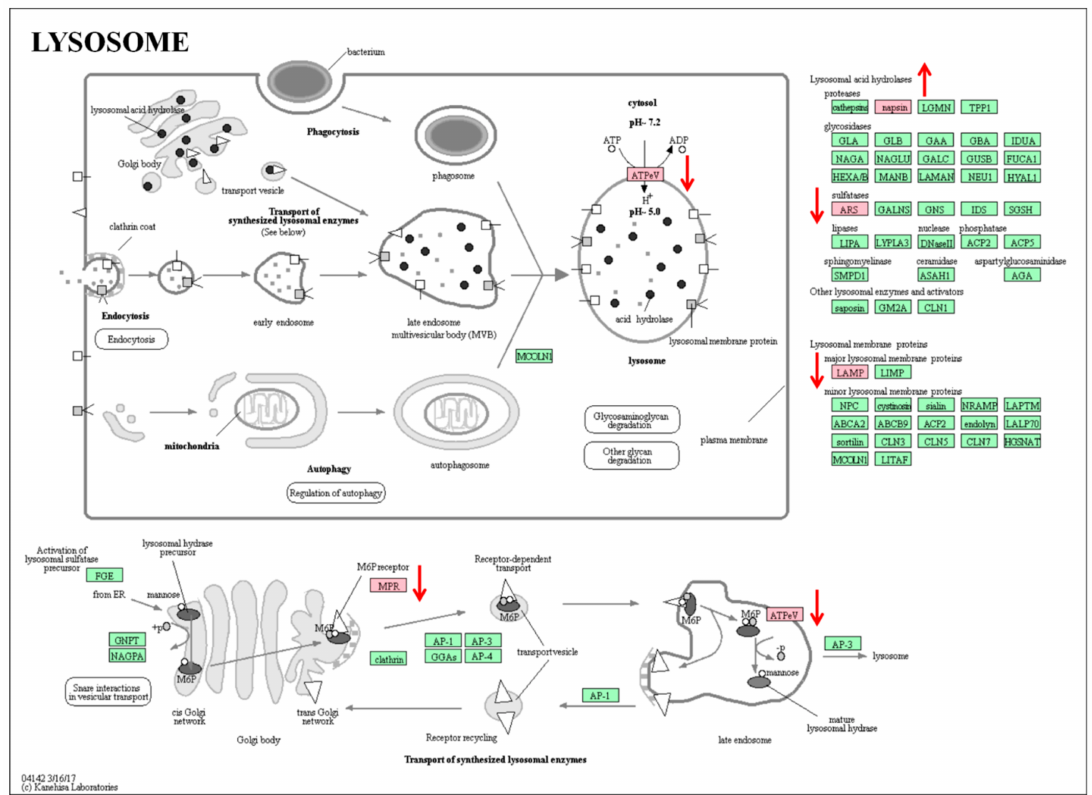
Figure 9. Overlapping differential proteins in KEGG pathway of